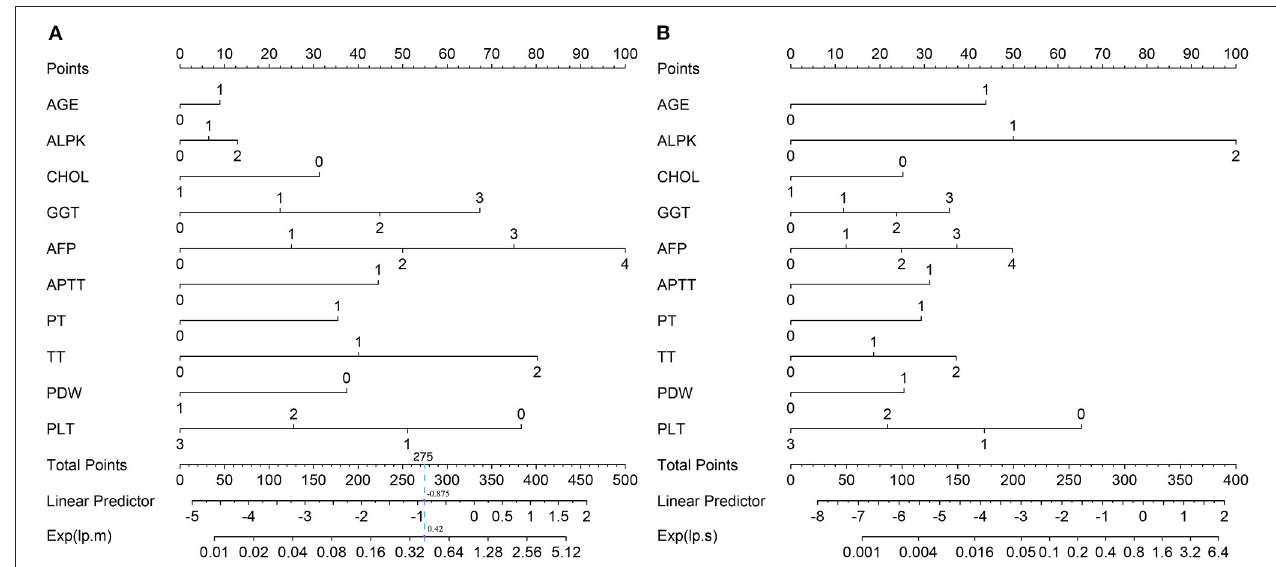
FIGURE 2 | The multinomial nomogram for the prediction of mild-moderate fibrosis (A) and severe fibrosis/cirrhosis (B) .